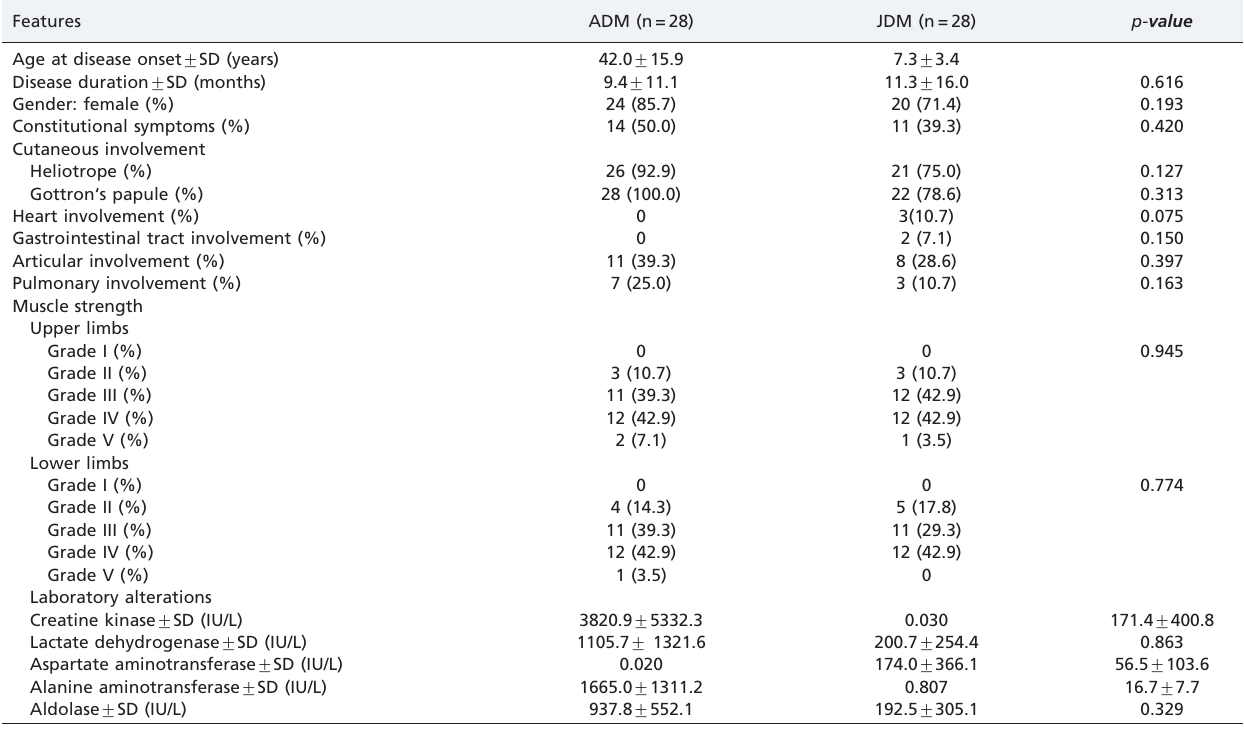
Table 1 - Clinical and laboratory features of adult and juvenile dermatomyositis.